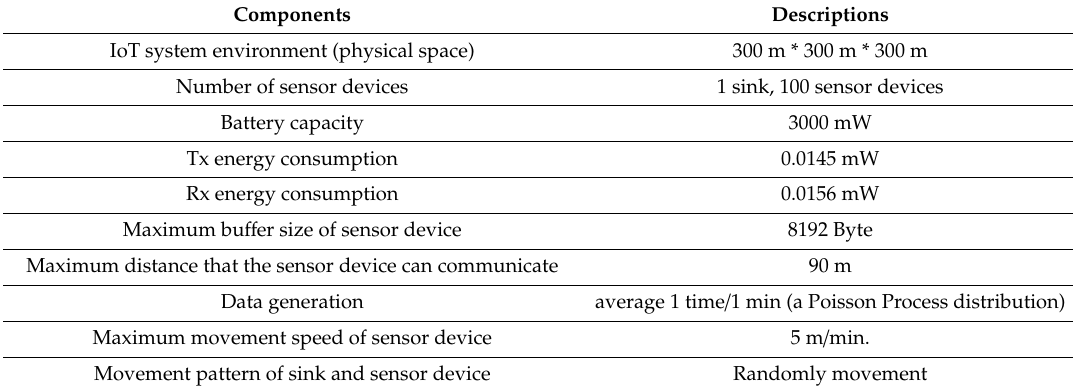
Table 4. Simulation environment of 3-D GM-MAC.